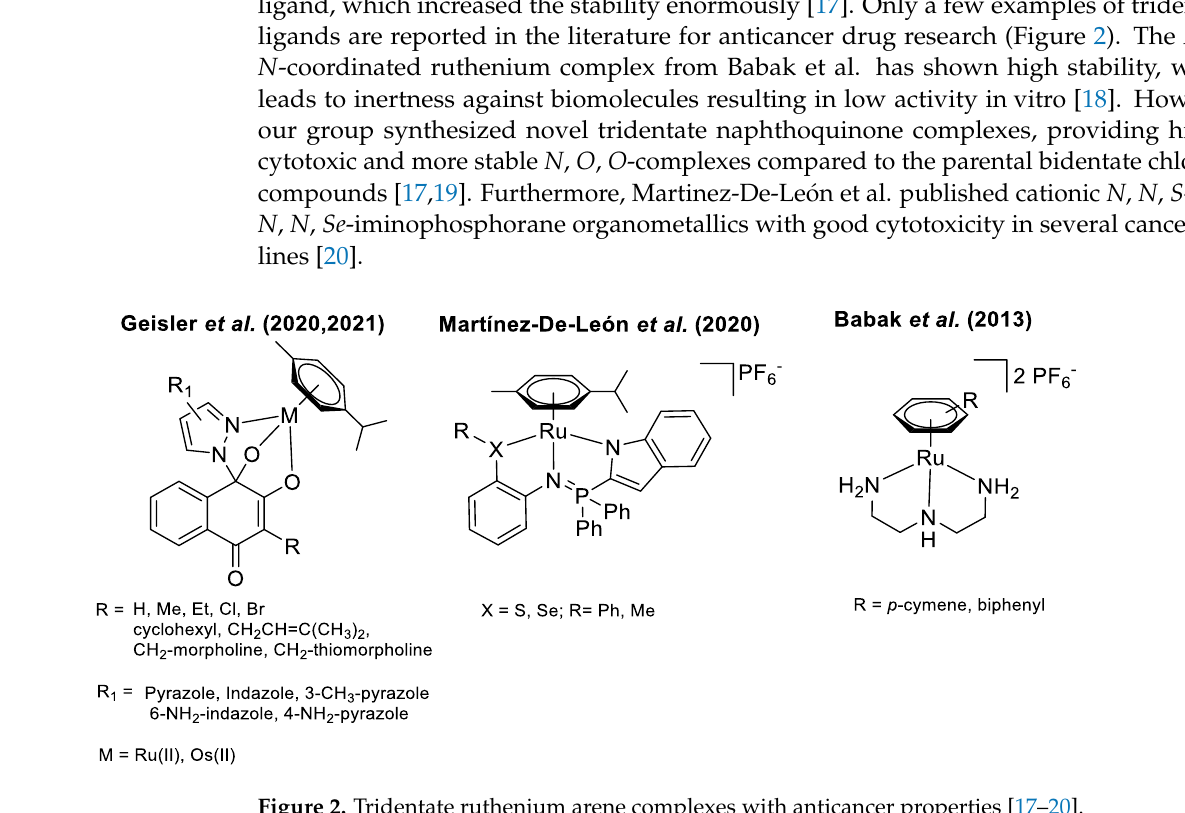
Figure 2. Tridentate ruthenium arene complexes with anticancer properties [17 –